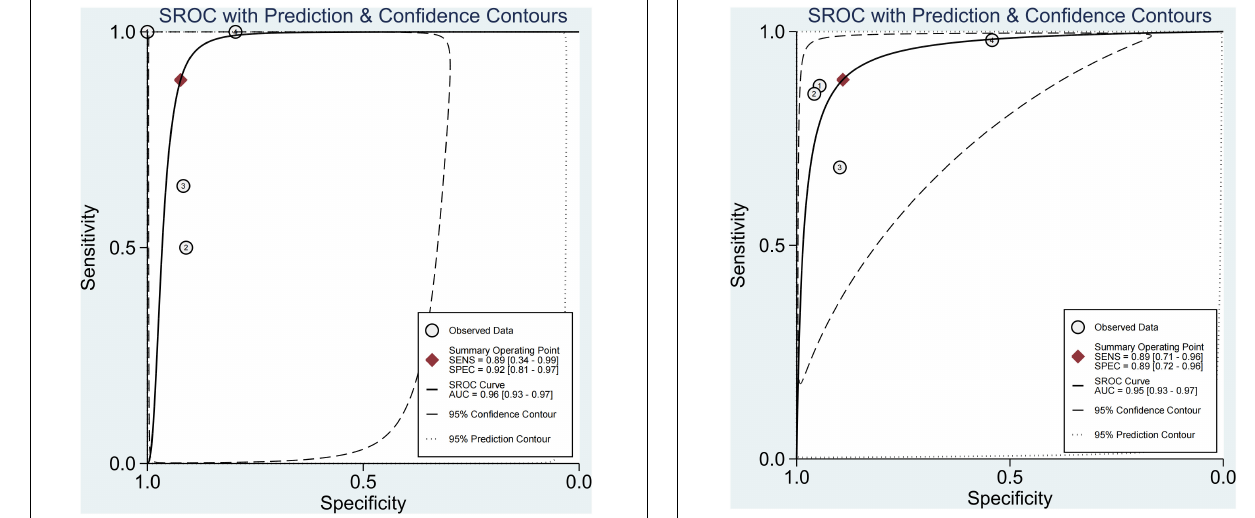
fibrosis are lacking. This meta-analysis found that the sensitivity and specificity for diagnosing significant fibrosis were 90% (95% CI, 69–97) and 96% (95% CI, 85–99). Among them, TE had